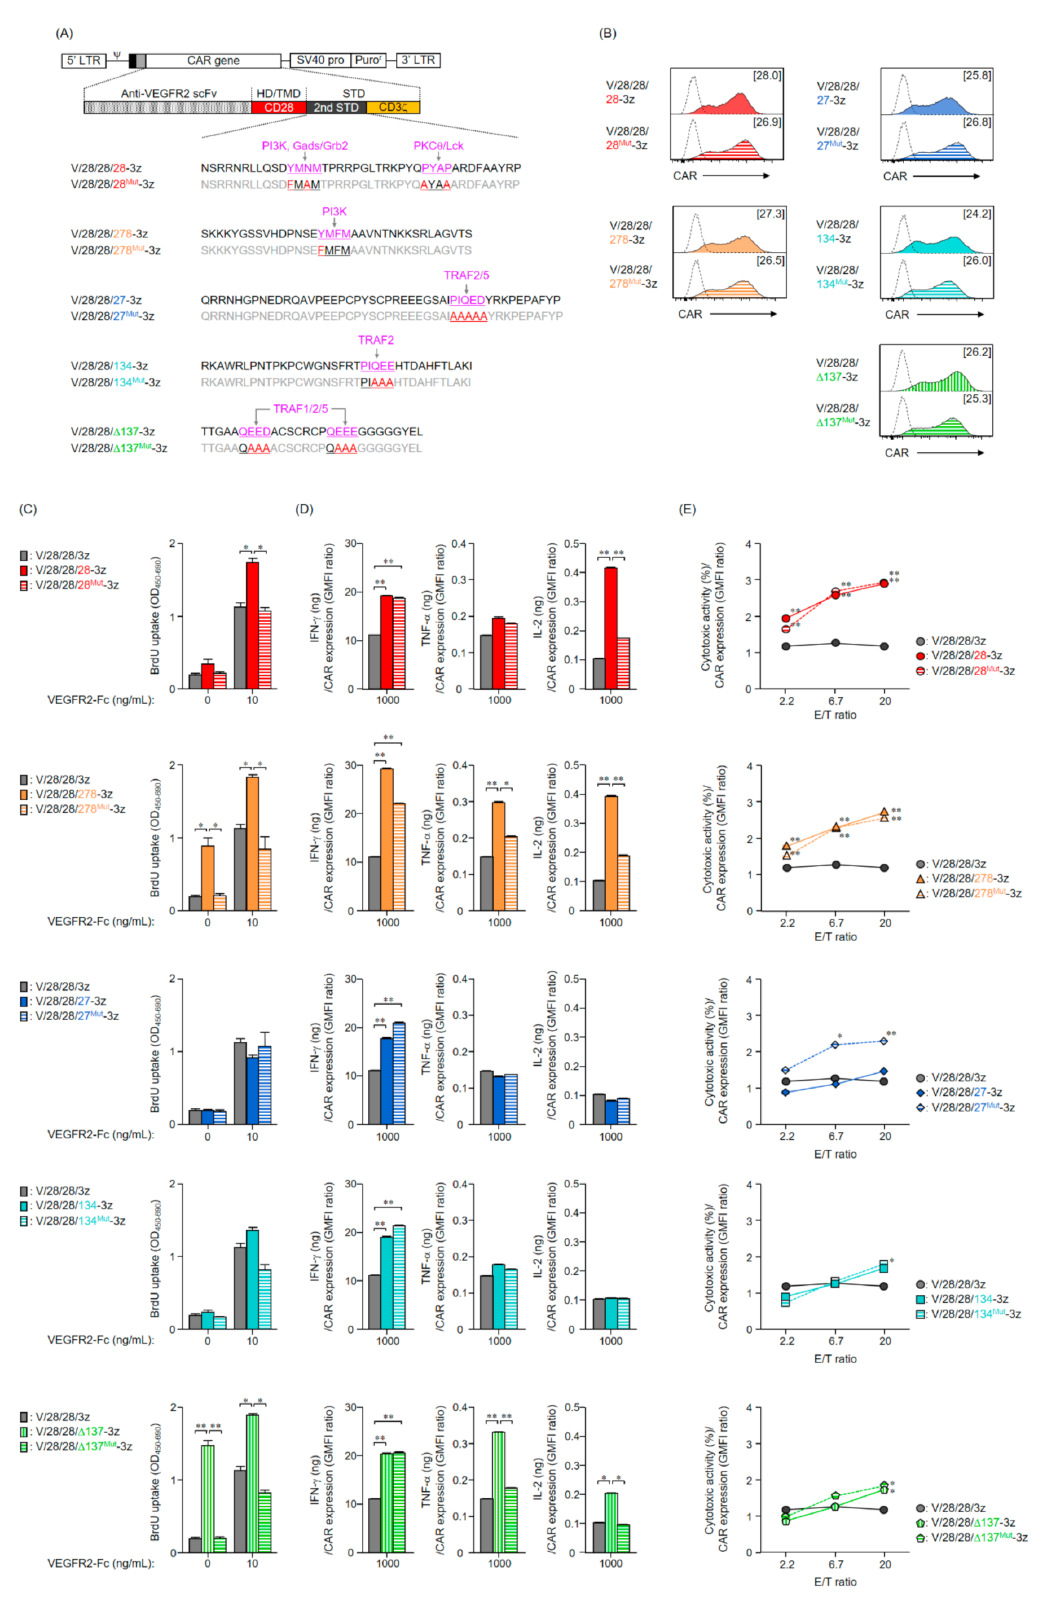
Figure 3. Functional characteristics of mouse T cells expressing second-generation CARs that cannot input the 2nd STD signals. ( A ) Amino acid sequence of STDs derived from costimulatory molecules in second-generation CARs. Adaptor molecules that bind to the 2nd STD in second-generation CAR and their binding regions are shown in magenta.